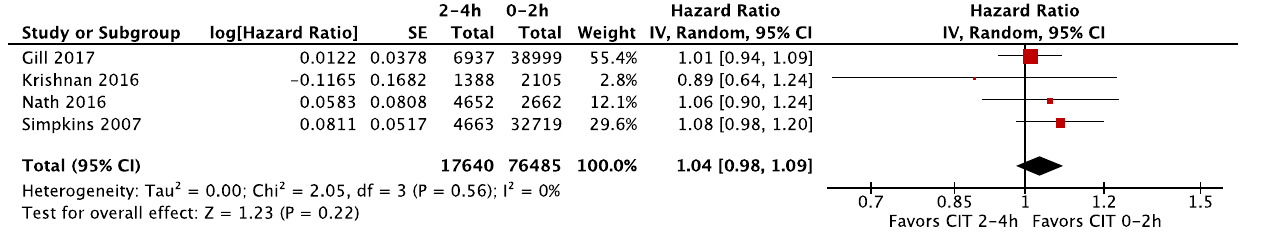
Figure 9. Five-year graft survival hazard ratio; CIT of 0–2 h versus 2–4 h. CIT: cold ischaemia time.